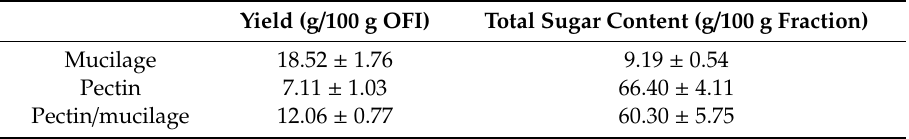
Table 2. Extraction yields and total sugar content of three soluble fibre fractions from Opuntia ficus indica cladode powder (OFI).